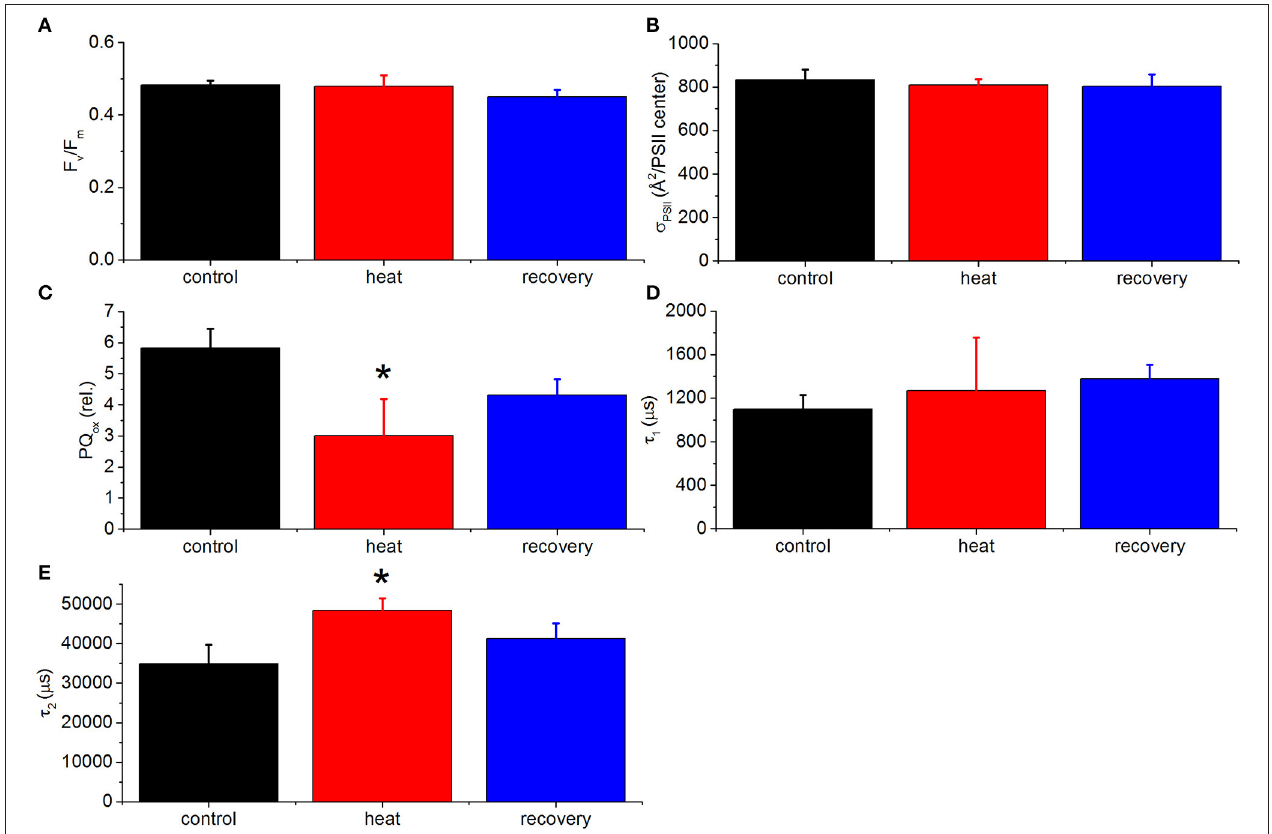
FIGURE 7 | Calculated FRRf parameters of P. decussata . F v / F m (A) , functional absorption cross-section of PSII (B) , relative oxidation state of the plastoquinone pool (PQ ox ) (C) , τ 1 (D) , and τ 2 (E) . Measurements were done at 25 ◦ C (control, black line), at 33 ◦ C (heat, red line) and 25 ◦ C after the heat treatment (recovery, blue line). Representative FRRf traces are shown in Figure 6 . Statistically significant differences are shown with asterisks ( p < 0.05). Error bars are standard errors of mean (SEM), n =